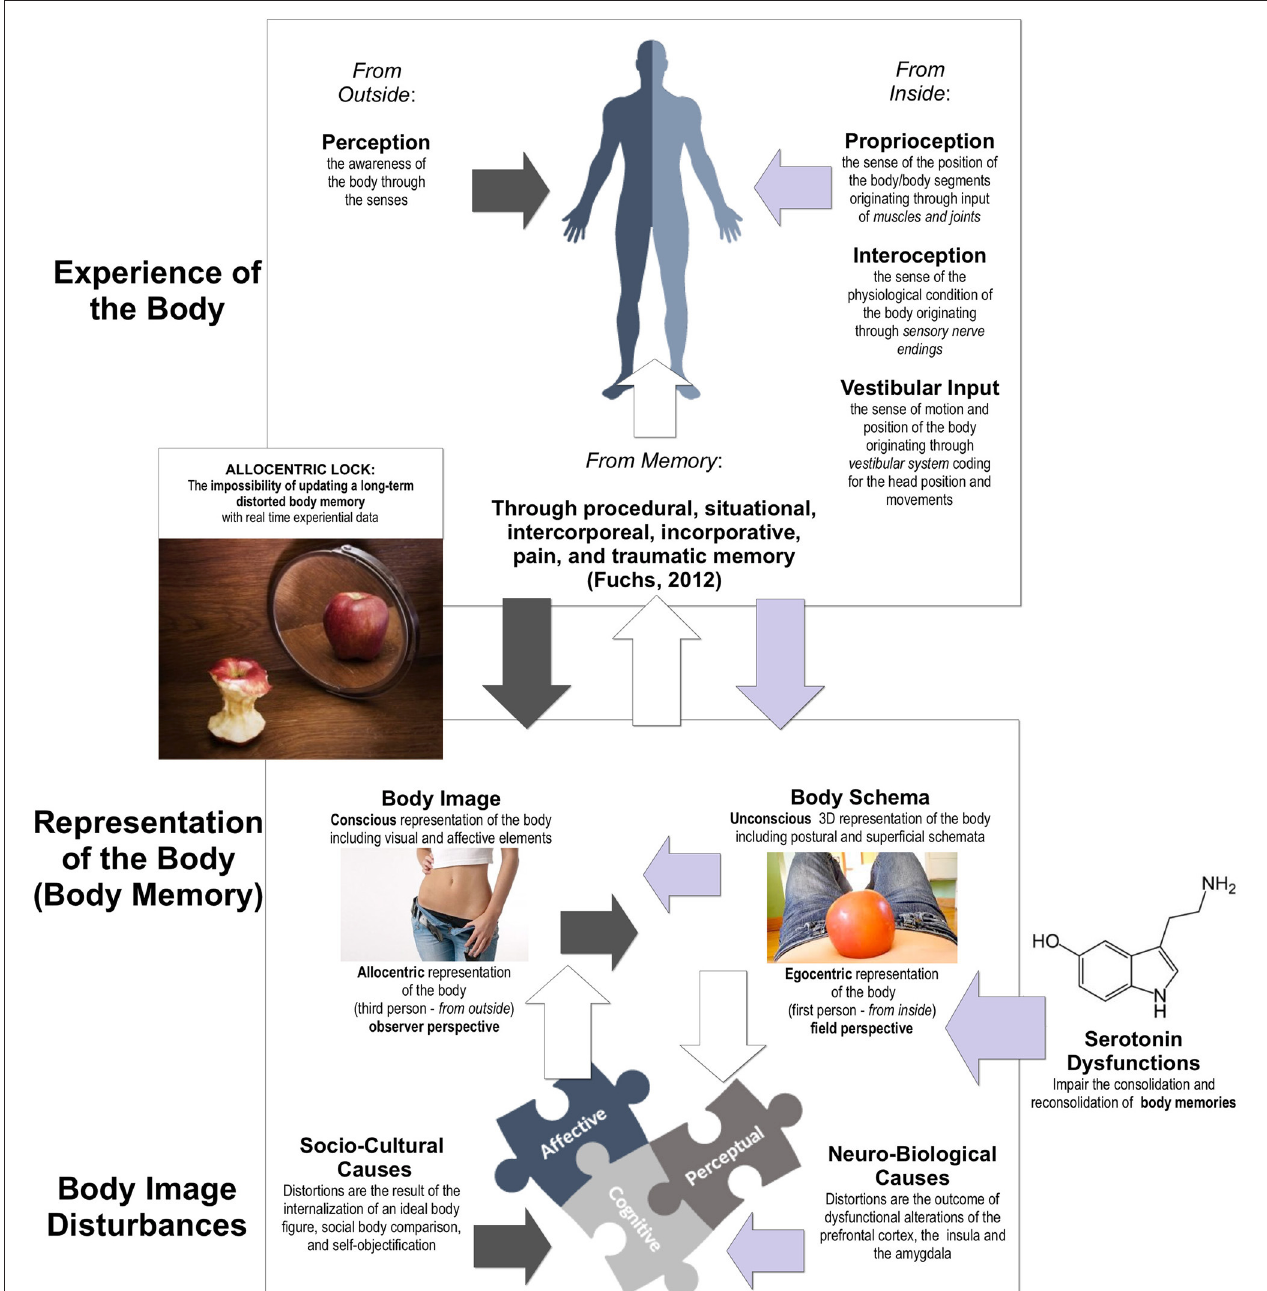
FIGURE 1 | Body Image Disturbances and their link with the Allocentric Lock